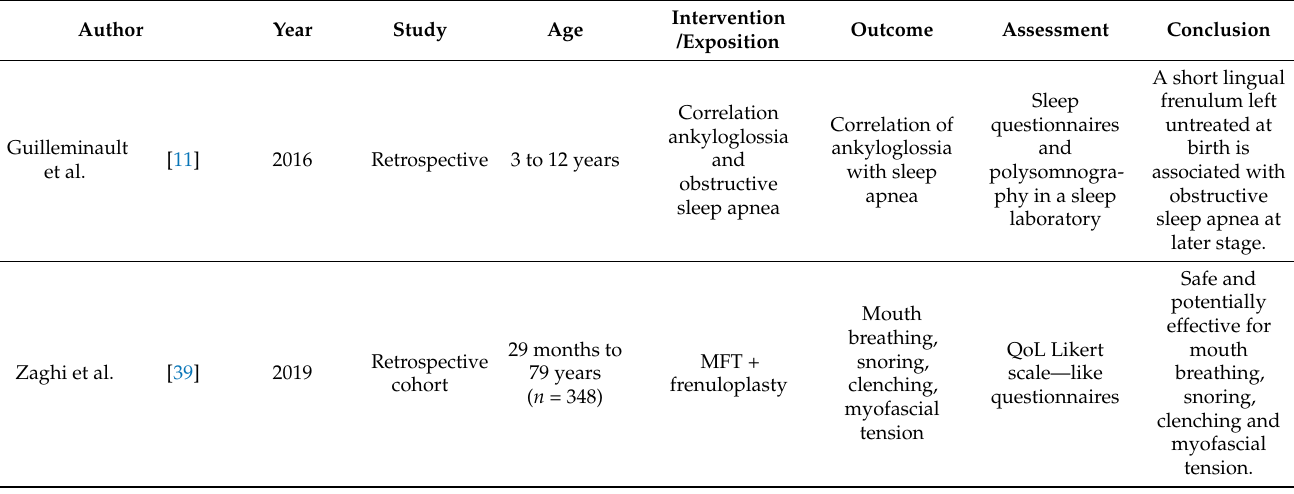
Table 1. Summary of systematic review on OSA and